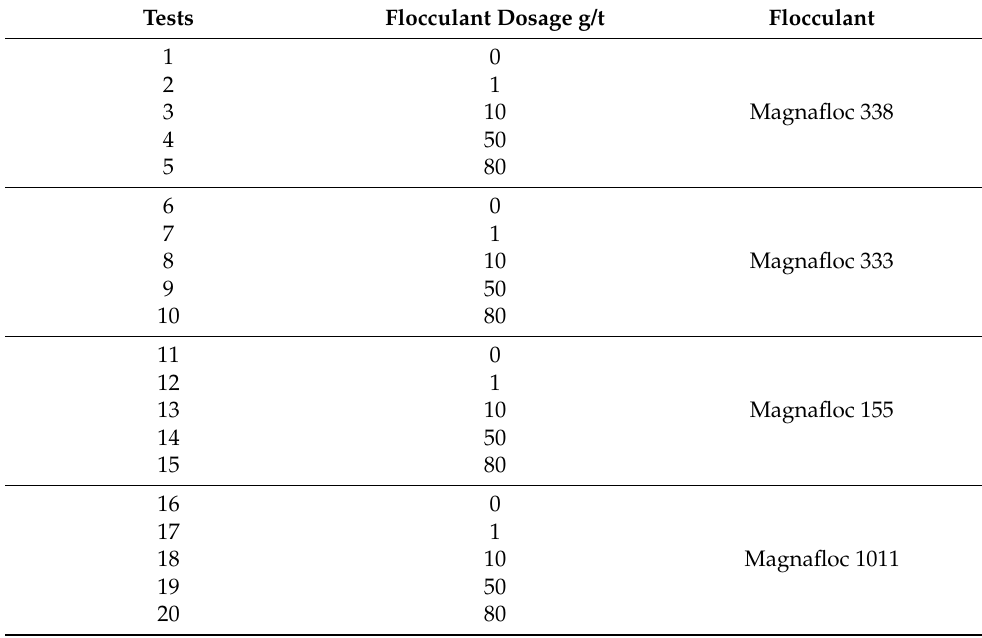
Table 4. Experimental design preliminary tests.